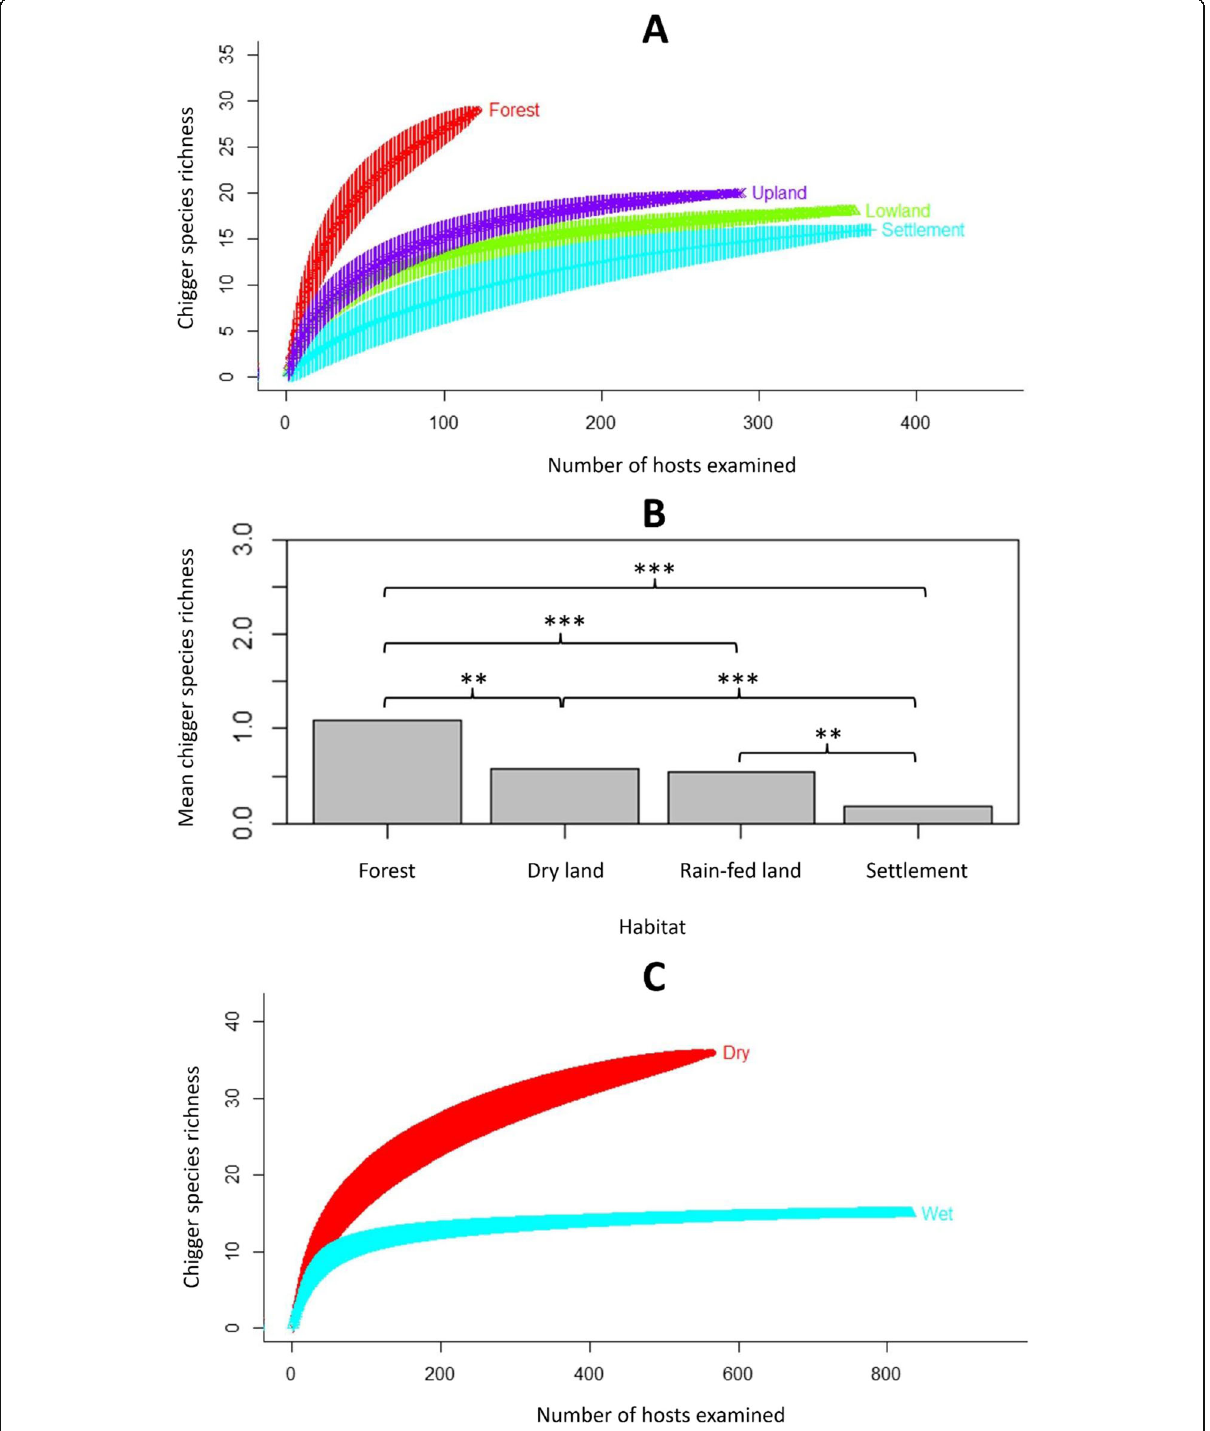
Fig. 1 Effect of habitat and season on chigger species richness. a Chigger species accumulation curves among different habitats at the host population level. b Mean chigger species richness per host individual by habitat type. c Chigger species accumulation curves between the dry (red) and wet (blue)